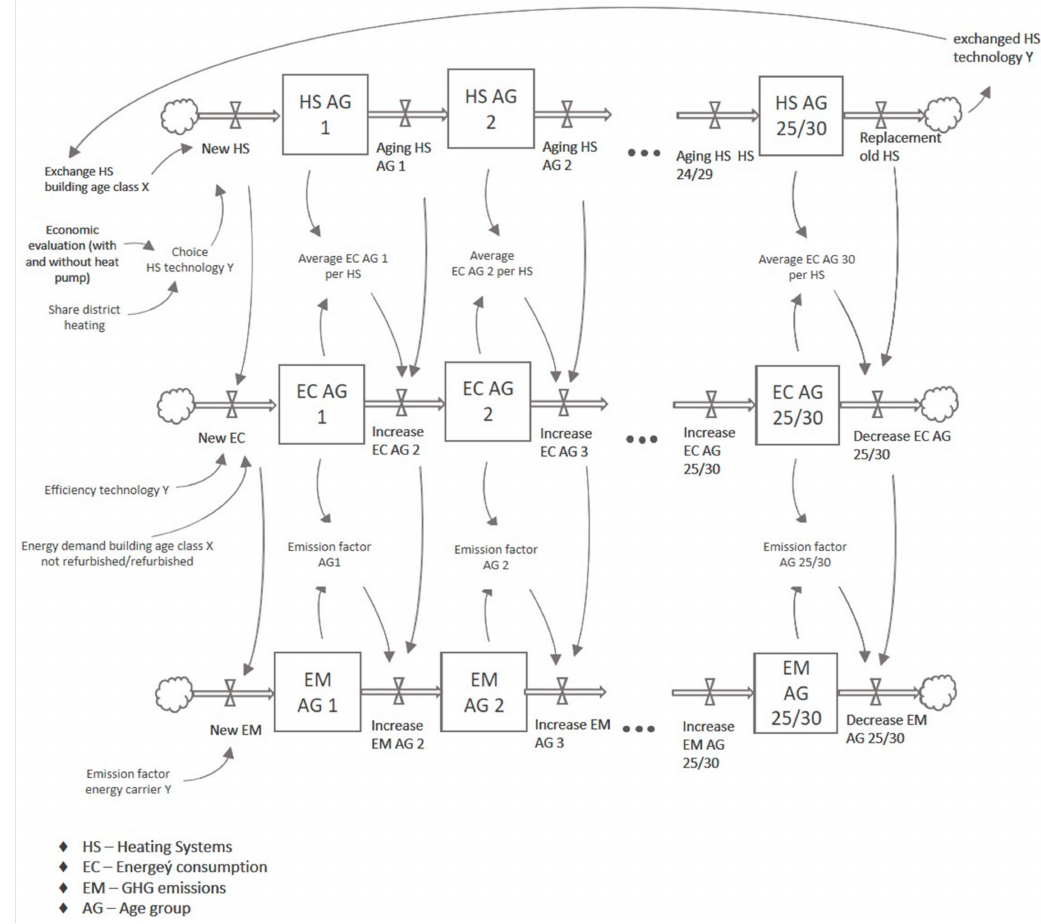
Figure 2. Aging chain co-flow structure of the supply side for building age class X and technology Y, derived from Schmidt et al. [36].